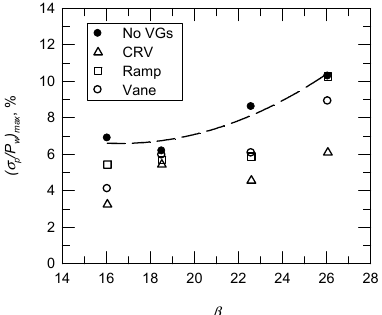
Figure 13. The effect of MVGs on peak pressure fluctuations.